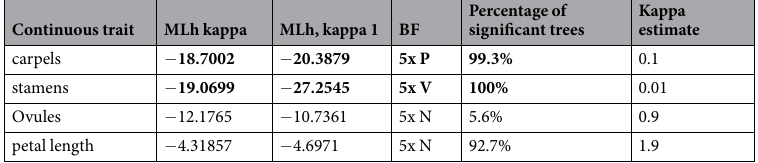
Table 2. Results of test for significant deviation from a Brownian motion model of evolution. MLh kappa = Best marginal likelihood of the stepping stone sampler of the model with the estimation of kappa, MLh kappa 1 = Best marginal likelihood of the stepping stone sampler of the model with kappa set to 1. BF = Bayes factor tests, V = very strong indication, P = positive indication and N = no indication for a deviation of kappa from 1.0. In bold are the results which show a significant deviation from a Brownian motion model of